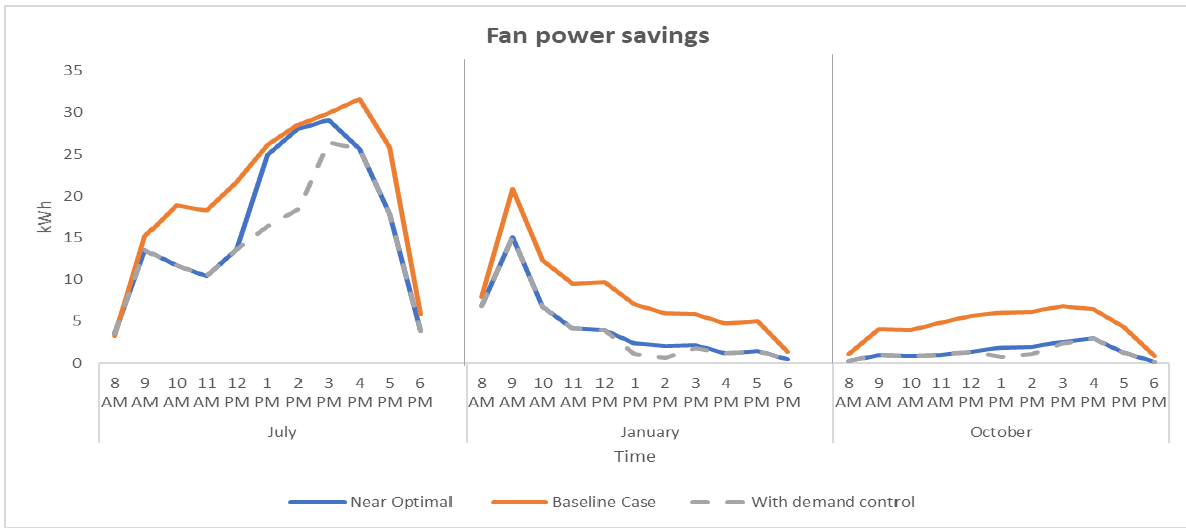
Figure 12. The total fan power savings for each day being analyzed.